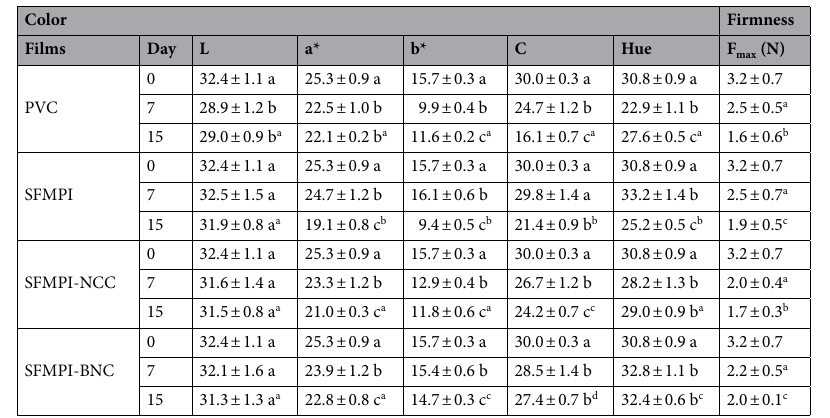
Table 2. Color profile and firmness of strawberries in containers sealed with PVC, SFMPI, SFMPI-NCC and SFMPI-BNC films over 15 days storage at 10 °C. Color Evaluation: Different letters within same columns, same factor and same film applied indicate statistically significant differences. Different superscript letters amongst same factors, regarding the 15th day of storage applied indicate statistically significant differences ( p < 0.05). Firmness Evaluation: Different letters within same column (firmness for each applied film regarding the 7th and 15th day of storage) or at 15th day of storage (all films) indicate statistically significant differences ( p < 0.05).